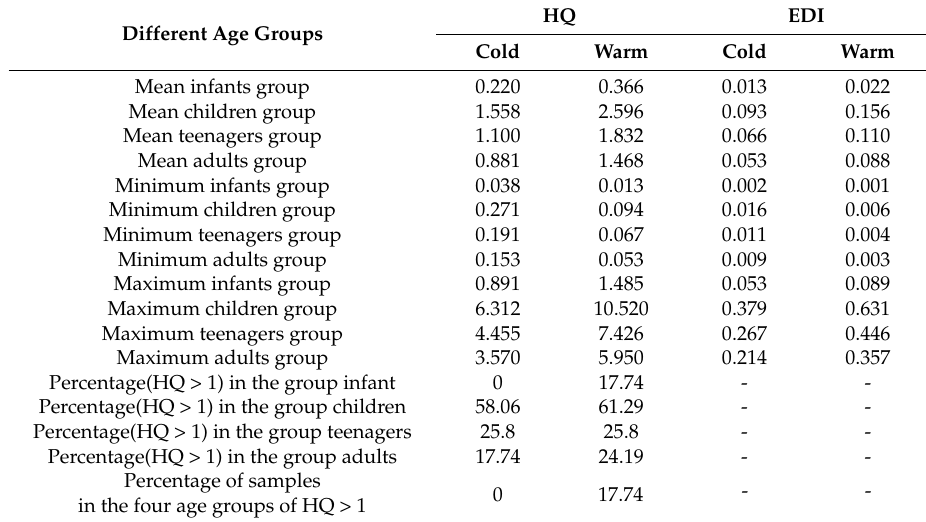
Table 4. HQ and Estimated Daily intake (EDI) values in cold and warm seasons for different for different age groups (infants, children, teenager and